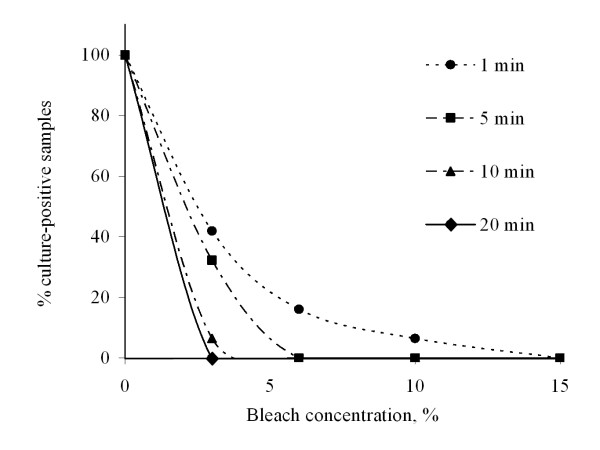
Bleach sterilization. M. tuberculosis viability after treatment of sputum specimens with 4 different bleach concentrations for 4 different exposure times, i.e. a total of 16 combinations of bleach concentrations and exposure times. All control specimens were culture-positive.